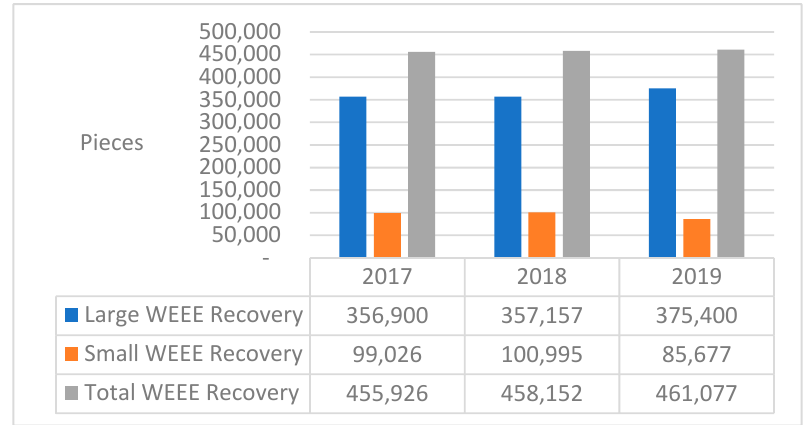
Figure 6. Electronic waste return amount of J company from 2017 to 2019.